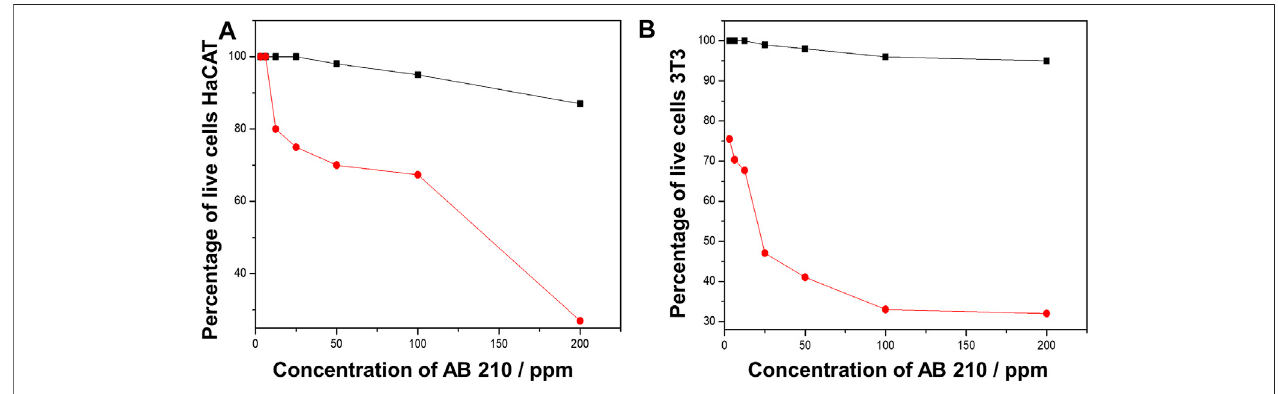
FIGURE9|(A) Percentage oflivecellsHaCAT vs concentrationofAB210 preparedon theday ofanalysis(black line) andstoredat 2 – 4 ° Cfor14days (redline). (B) Percentage of live cells 3T3 clone A31 vs concentration of AB210 prepared on the day of analysis (black line) and stored at 2 – 4 ° C for 14 days (red line).